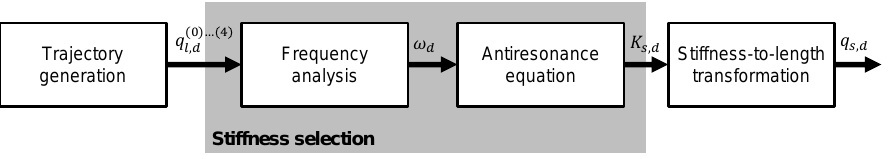
Figure 5. Block diagram of stiffness control strategy (modified version of